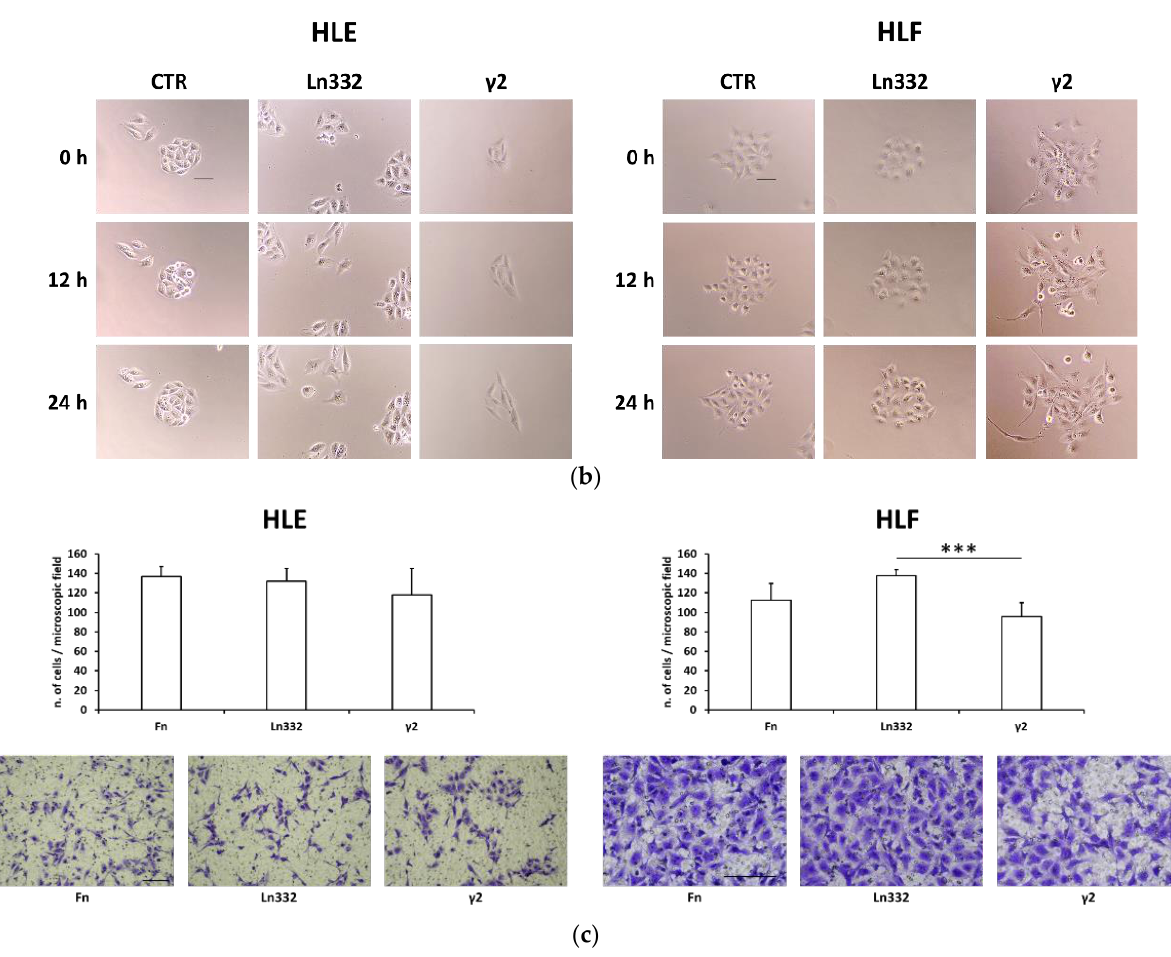
Figure 1. Laminin-332 γ 2 chain promotes adhesion, scattering, and migration of HCC cells. ( a ) Cell adhesion assay. HLE or HLF cells were seeded on uncoated (BSA), fibronectin (Fn), laminin-332 (Ln332), or γ2 chain (γ2) -coated well surfaces and allowed to attach and spread for 30 minutes. Data are the means ± SD of triplicates; ( b ) scattering assay (File S1). Colonies made by 8–10 cells of HLE and HLF cells were left untreated or treated with soluble Ln332 (10 µg/mL) and γ2 (3.125 µg /mL) in serum free medium for 24 h; scale bar = 50 µm; a replicate experiment, including stimulation with hepatocyte growth factor (HGF, at the concentration of 100 ng/mL) as a positive control condition, is shown in Figure S1; ( c ) transwell migration assay. HLE and HLF cells were seeded on the top of the transwell membrane, previously coated with Fn, Ln332, or γ2 on the lower side and allowed to migrate for 16 h. Data are the means ± SD of five randomly chosen microscopic fields. T test (un-paired, two-tailed), *** p < 0.001 (vs. BSA in panel ( a )); and scale bar = 100 µm.